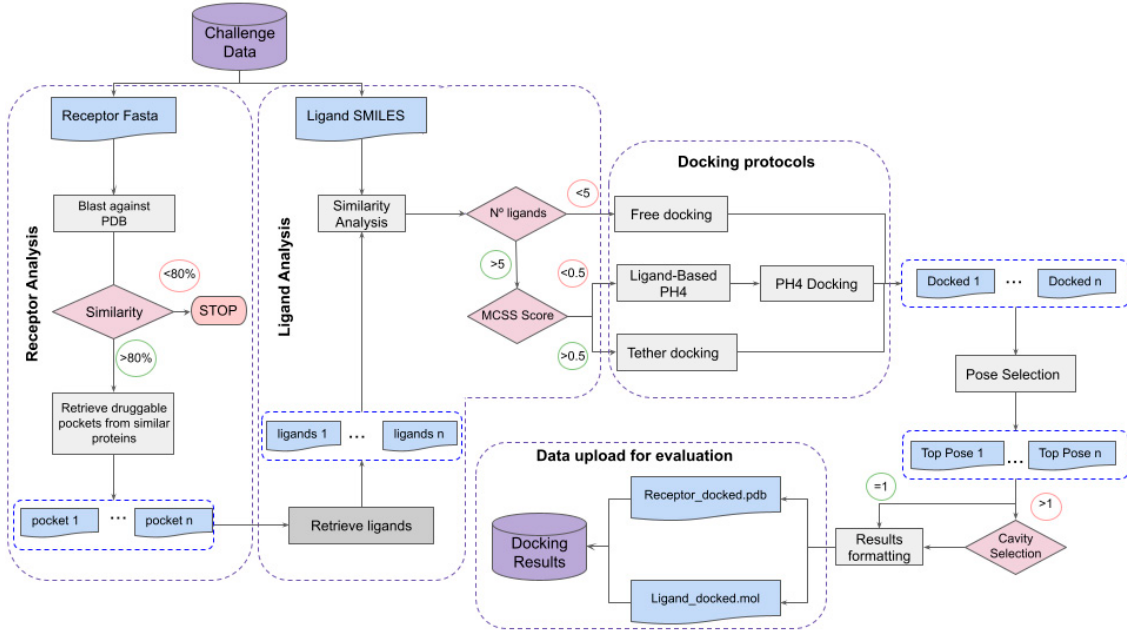
Figure 1. Workflow employed for pose prediction.